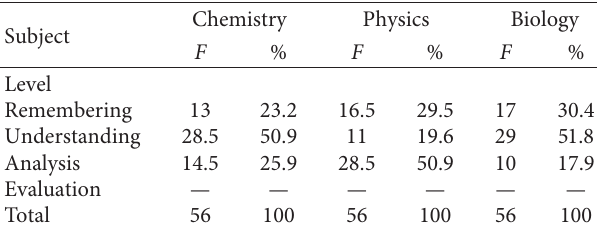
Table 5: Final examinations’ grade distribution for chemistry, physics, and biology based on grades for each